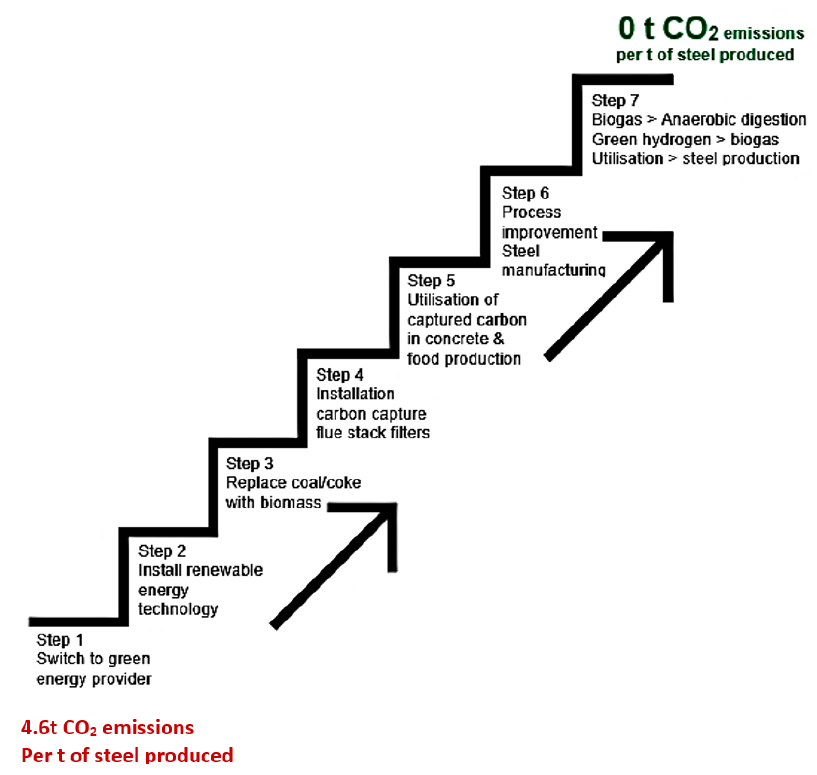
Figure 4. The seven steps to achieving net-zero carbon emissions steel production.